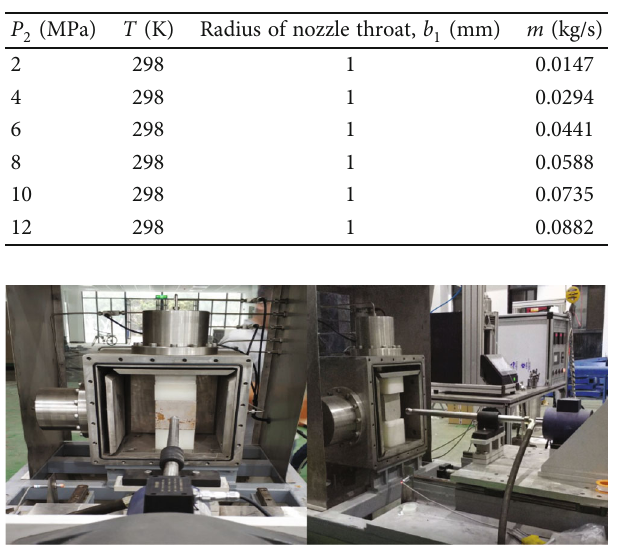
Table 3: Mass fl ow rate at nozzle outlet under di ff erent jet pressures.